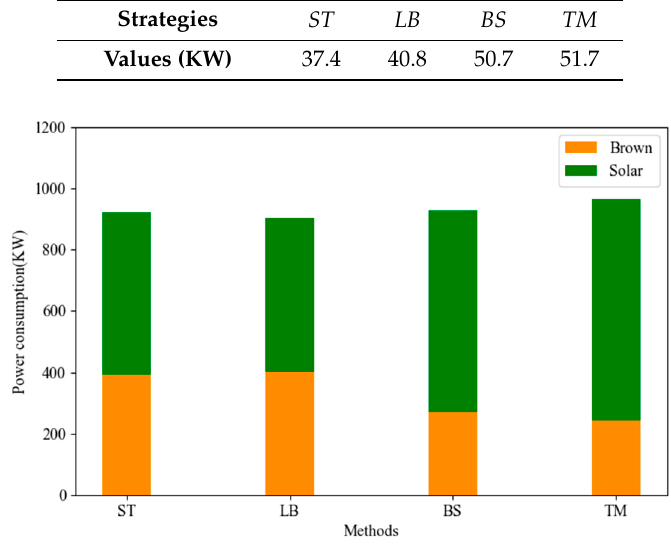
Figure 7. Power usage comparisons on a sunny day.